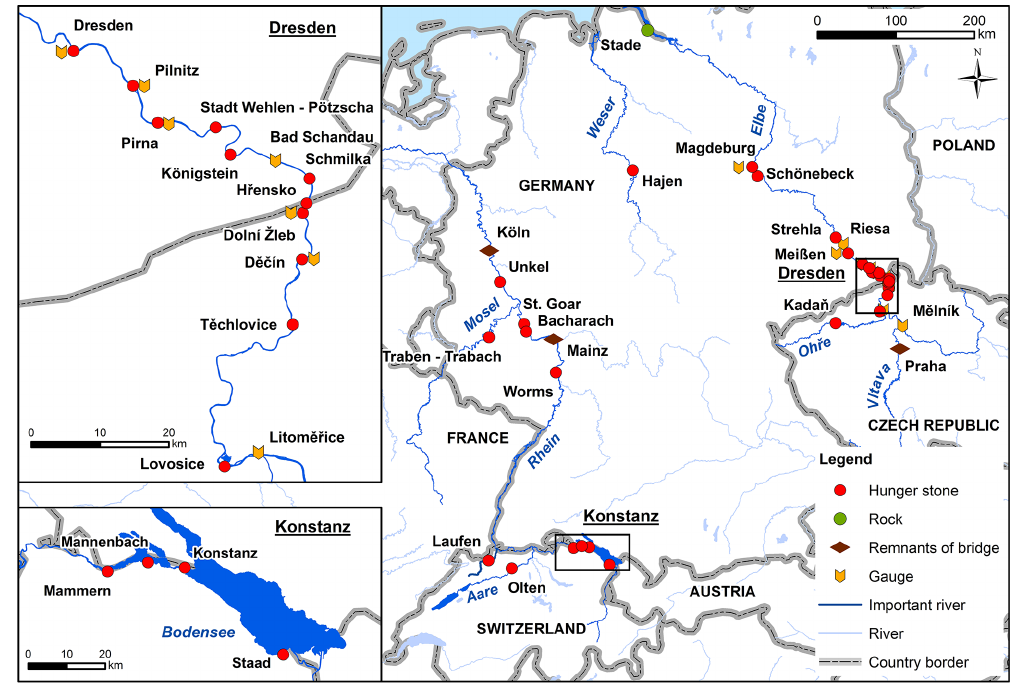
Figure 3. Central Europe and the occurrence of objects similar to the hunger stone in D ˇ e ˇ cín.